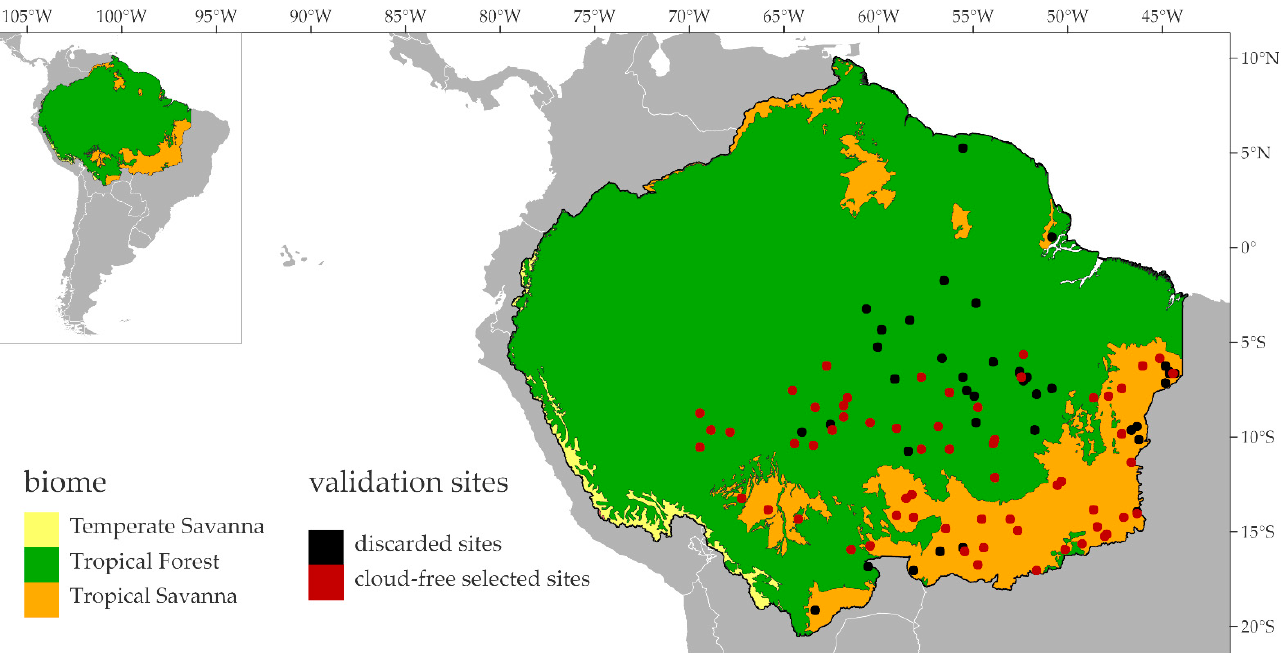
Figure 1. Amazon Socio-Environmental Information Network (RAISG) area. The figure shows the 100 reference sites (black + red) sampled to validate a Sentinel-2 burned area product produced within the RAISG project. Cloud-free reference data (red sites) were selected for the present study.